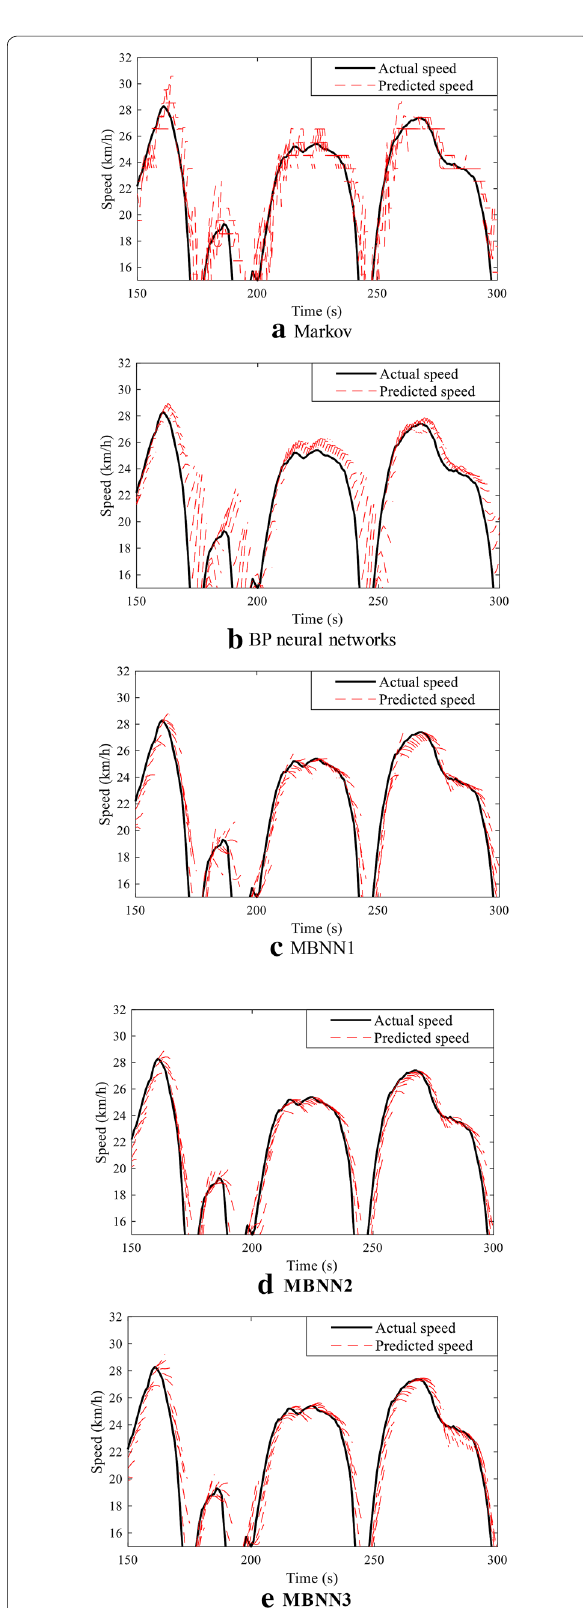
marizing the performance of the combined prediction